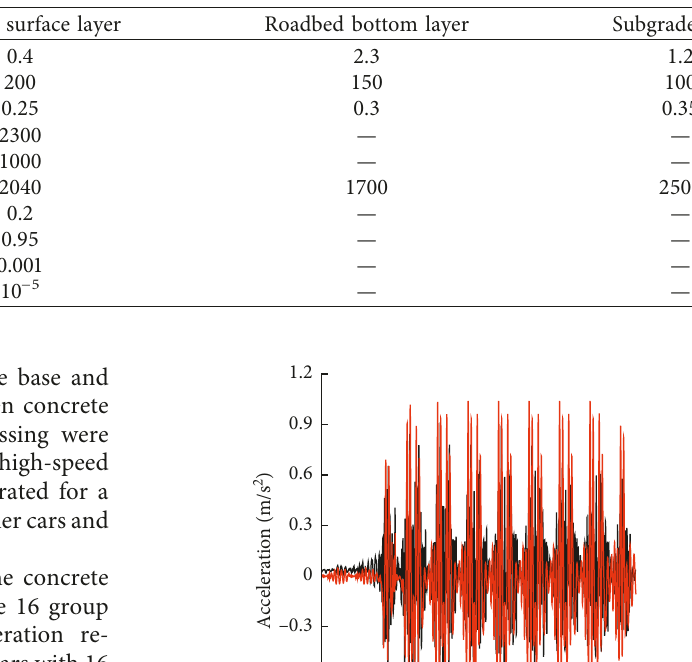
Table 3: Parameters of subgrade soil simulated.